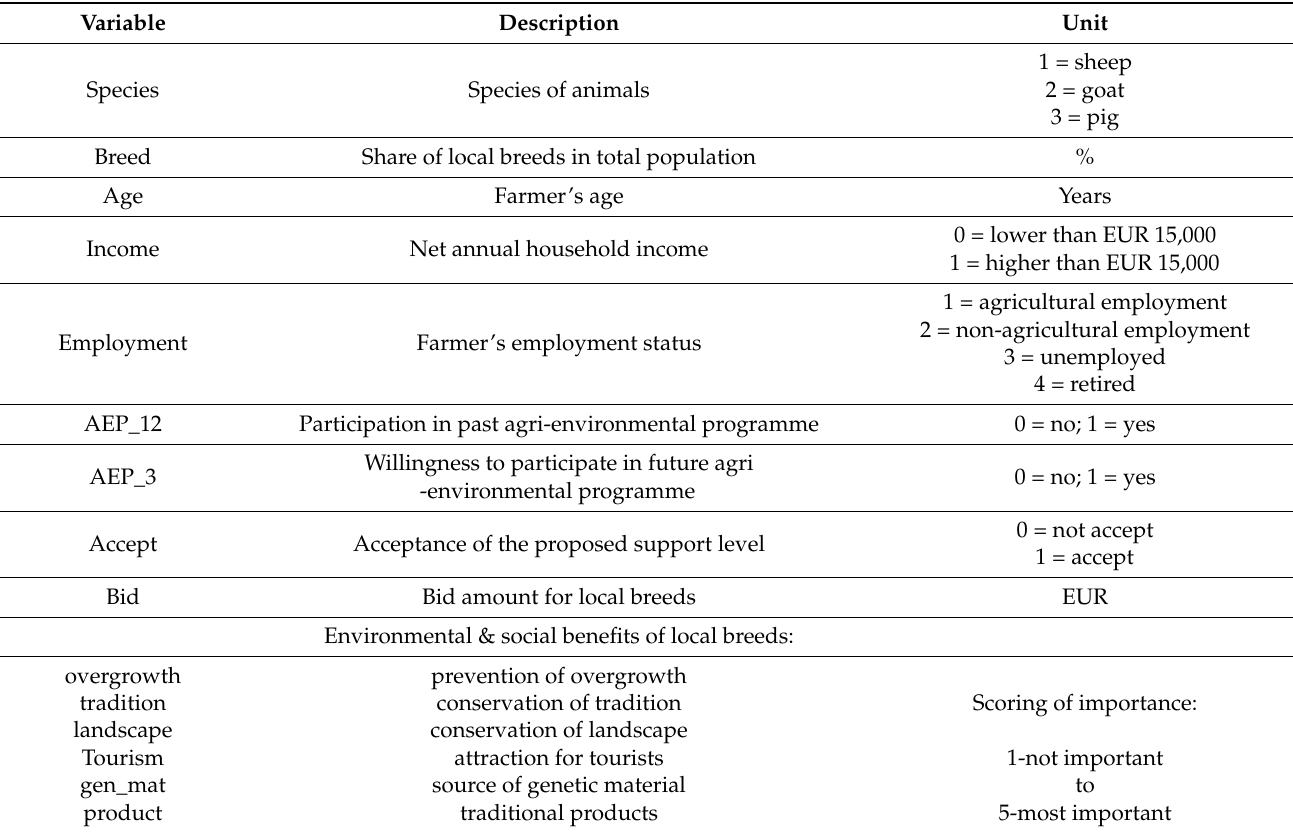
Table 3. WTA model